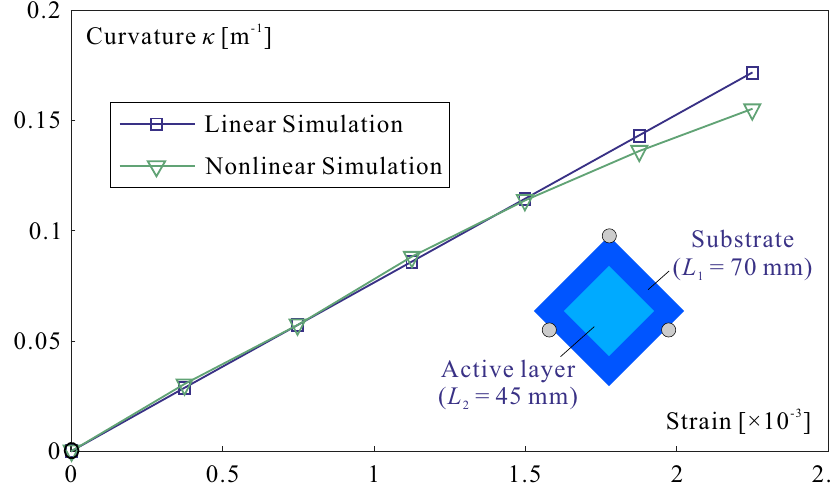
Figure 9. Relationship between the average curvature in the central pupil of 35 mm diameter and the misfit strain induced in the electrostrictive